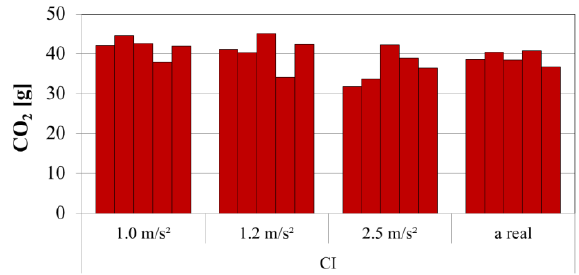
Fig. 20. CO 2 emission for different acceleration characteristics of a vehicle propelled with CI Euro 3 engine obtained during simulation using PTV Vissim